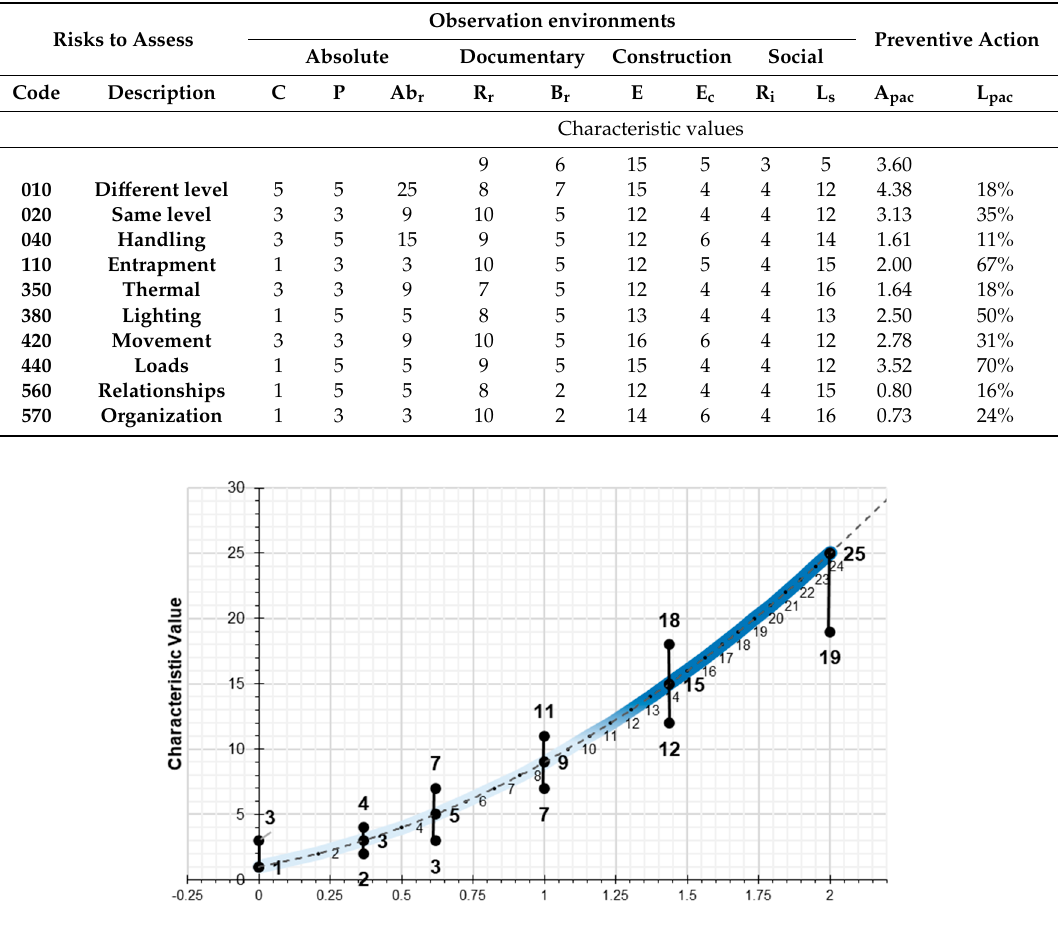
Table 10. Example of risk impact calculation.